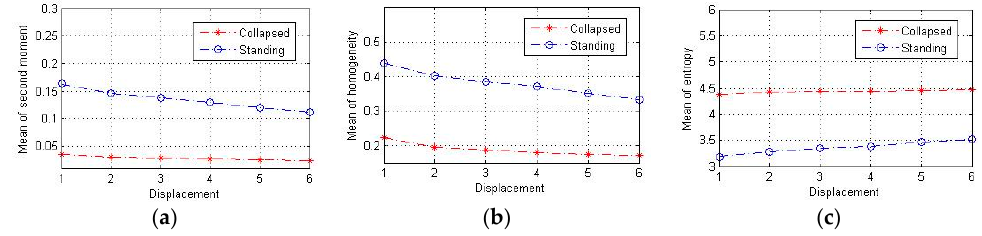
Figure 15. GLCM features with different displacements. ( a ) Mean of second moment; ( b ) Mean of homogeneity; ( c ) Mean of entropy.